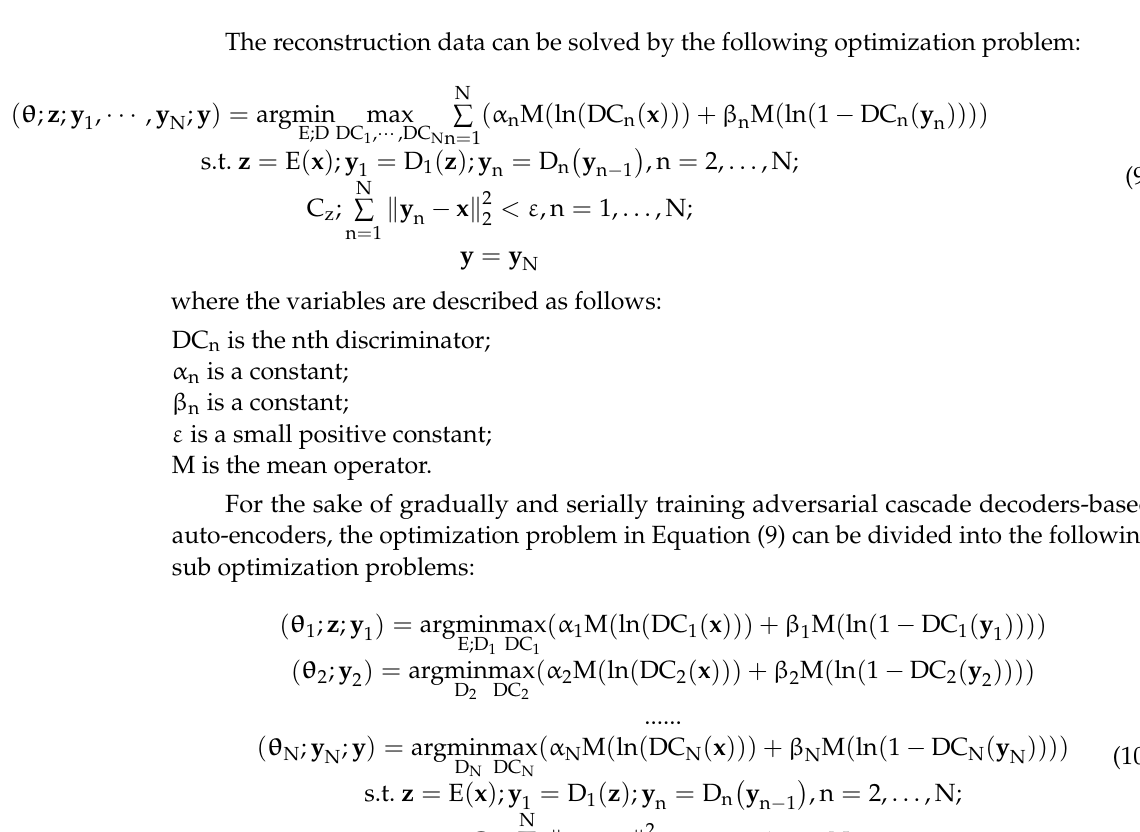
Figure 5. The architecture of adversarial cascade decoders-based auto-encoders.